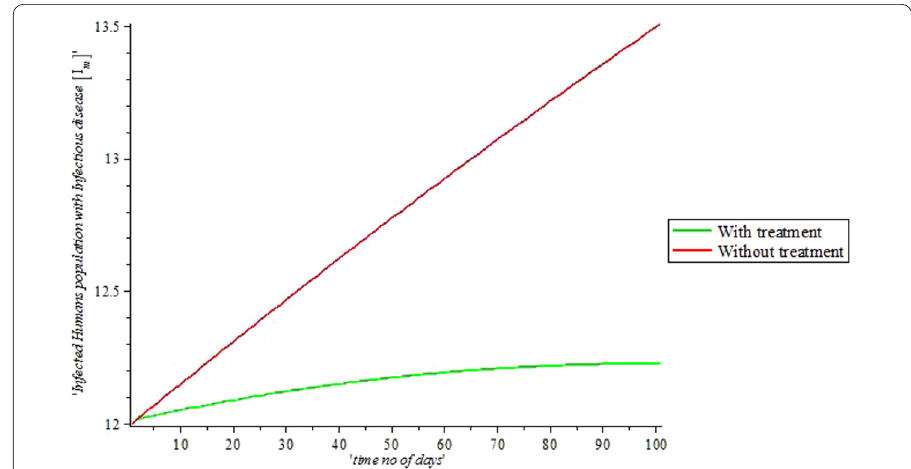
Figure 3 The optimal control strategy 1 using treatment only